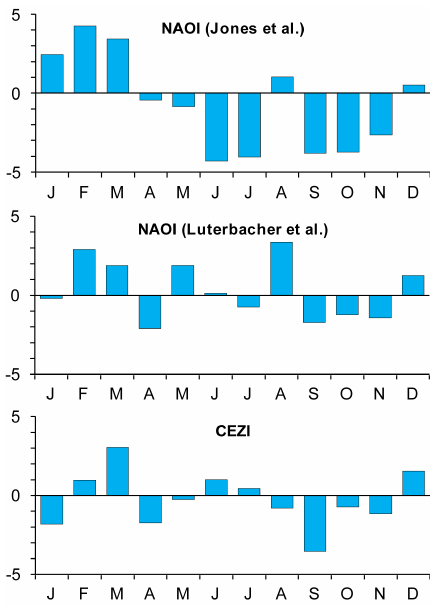
Figure 8. Annual variation in mean monthly NAOI (Jones et al., 1997; Luterbacher et al., 1999) and CEZI (Jacobeit et al., 2001) in 1842.